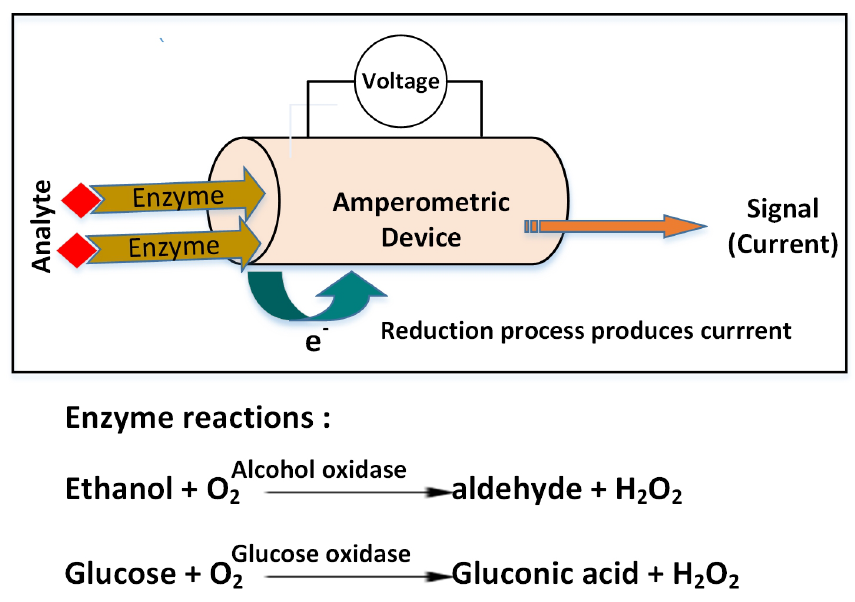
Figure 6. General scheme of amperomertic biosensors for detecting sugar and alcohol levels in process